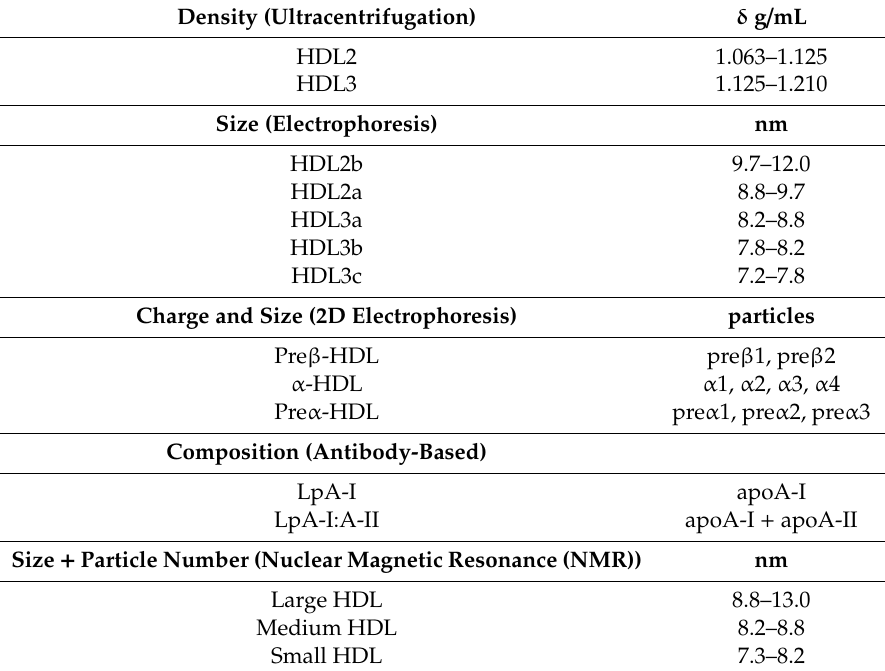
Table 1. High-density lipoprotein (HDL) subclasses depending on the isolation